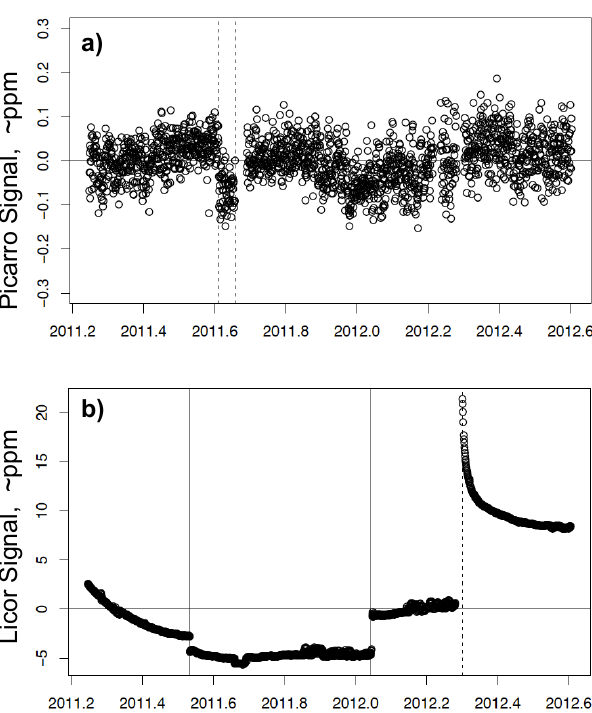
Fig. 12. Uncorrected signal minus the mean value for all = 407.77ppm) for the pe- CO2C3 measurements (assigned χ CO 2 riod 1 April 2011 to 9 August 2012 for the WGC (a) Li-cor and (b) Picarro analyzers. Dashed vertical lines in (a) correspond to 12 and 29 August 2011, a period when the CO2C2 reference tank was offline, which caused flow and pressure disruptions in the Picarro sample cell. Solid lines in (b) correspond to dates when the CO2 reference gas was changed. The dashed vertical line in (b) corre- sponds to 20 April 2012, when the analyzer was restarted after a power supply